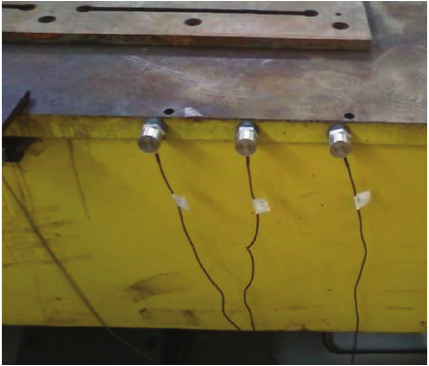
Figure 7: Calibration of acceleration